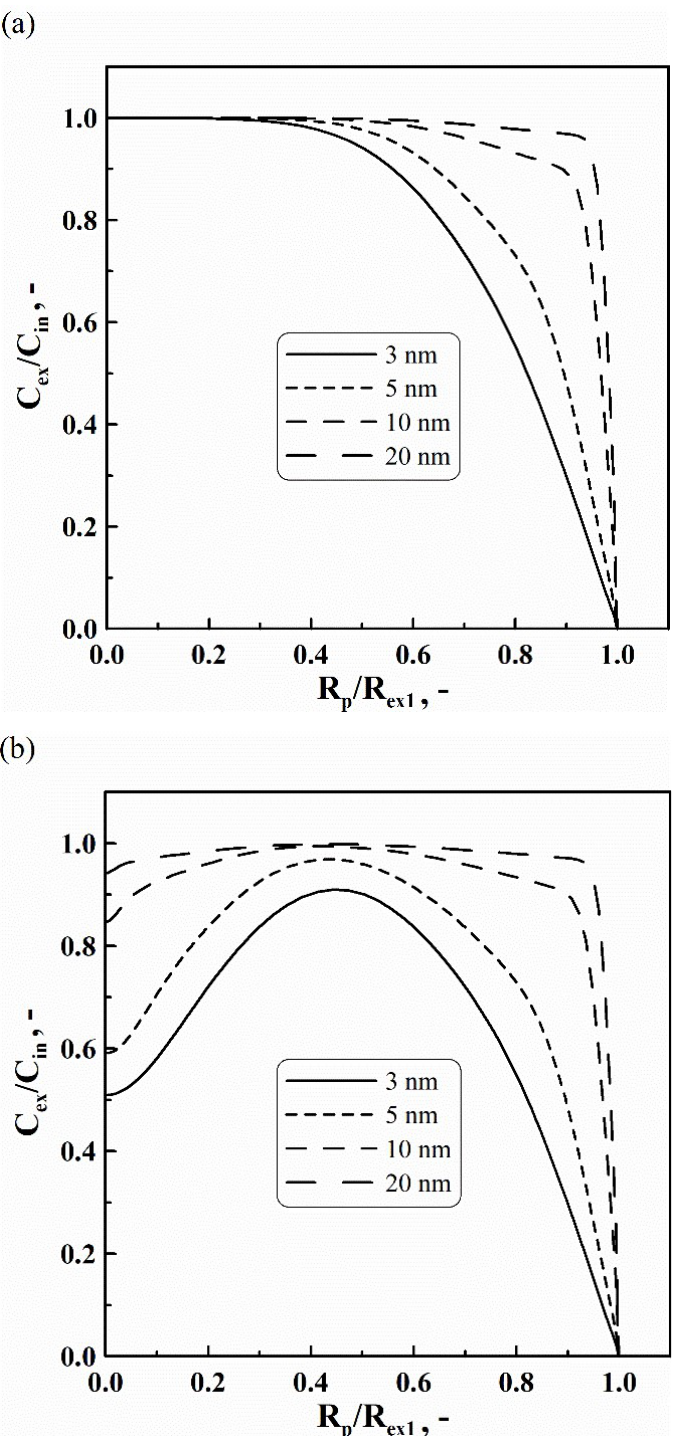
Figure 7. Concentration profile at outlet of the hollow tapered cylinder ( a ) without the conical column and ( b ) with the conical column for different particle diameters at the flow rate of 2 L/min.